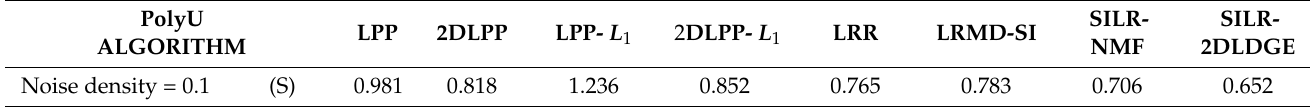
Table 4. The average CPU time consumed of the eight algorithms in the PolyU palmprint database.